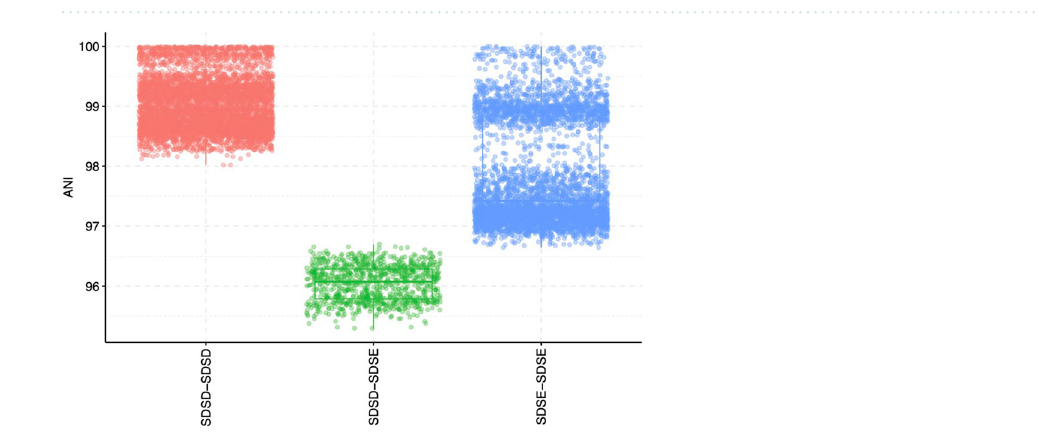
Figure 5. Heatmap of the average nucleotide identity between the whole genome sequences of both subspecies of Streptococcus dysgalactiae (n = 156) .